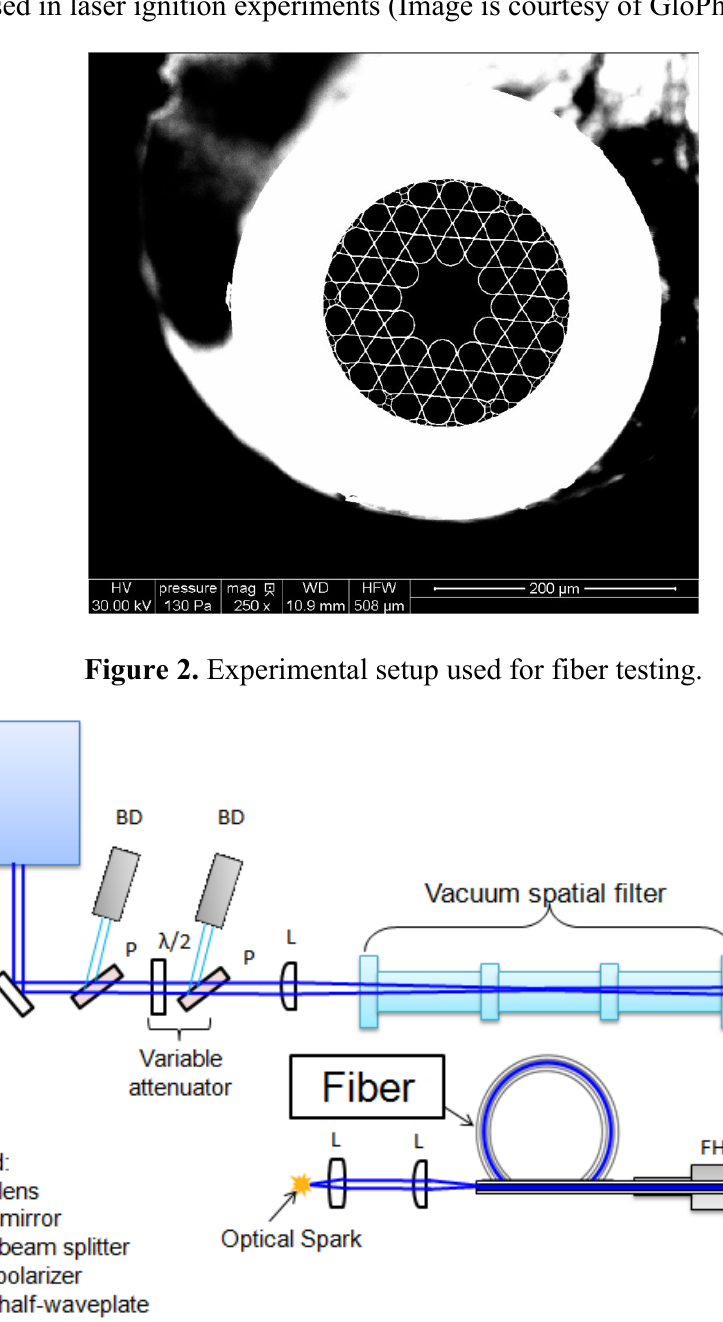
Figure 1. Backscattered SEM image of the kagome type hollow core photonic crystal fiber (HC-PCF) used in laser ignition experiments (Image is courtesy of GloPhotonics).